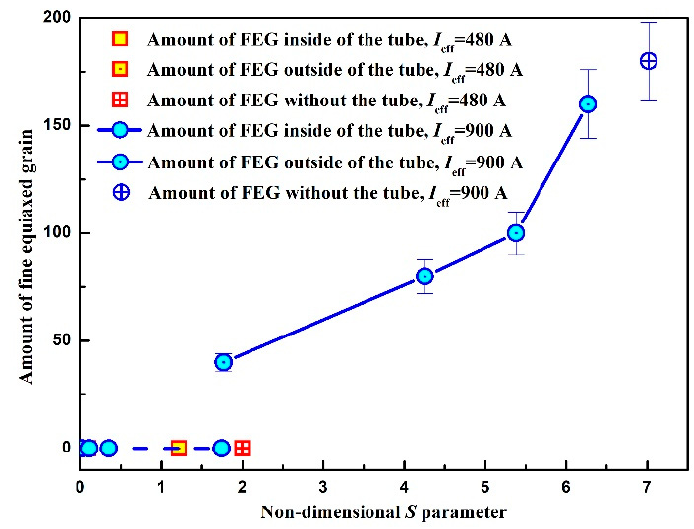
Figure 9. Relationship between N in di ff erent regions of mold embedded stainless mesh below the mesh plate and non-dimensional S parameter.